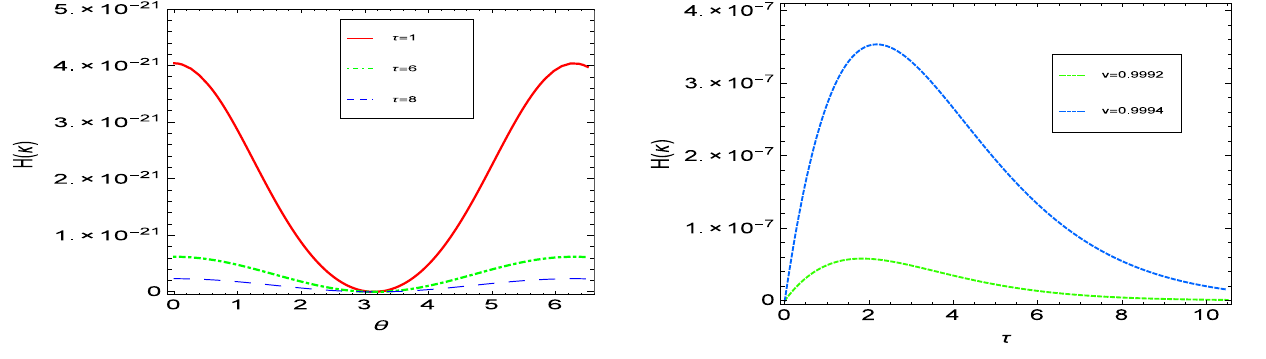
Fig. 3 QFIintheestimationofthedeformationparameterasafunction of the effective time τ with v = 0 . 9992 , 0 . 9994, respectively. By preparing the detector initially in the exited state θ = 0 and the effective deformation parameter κ =